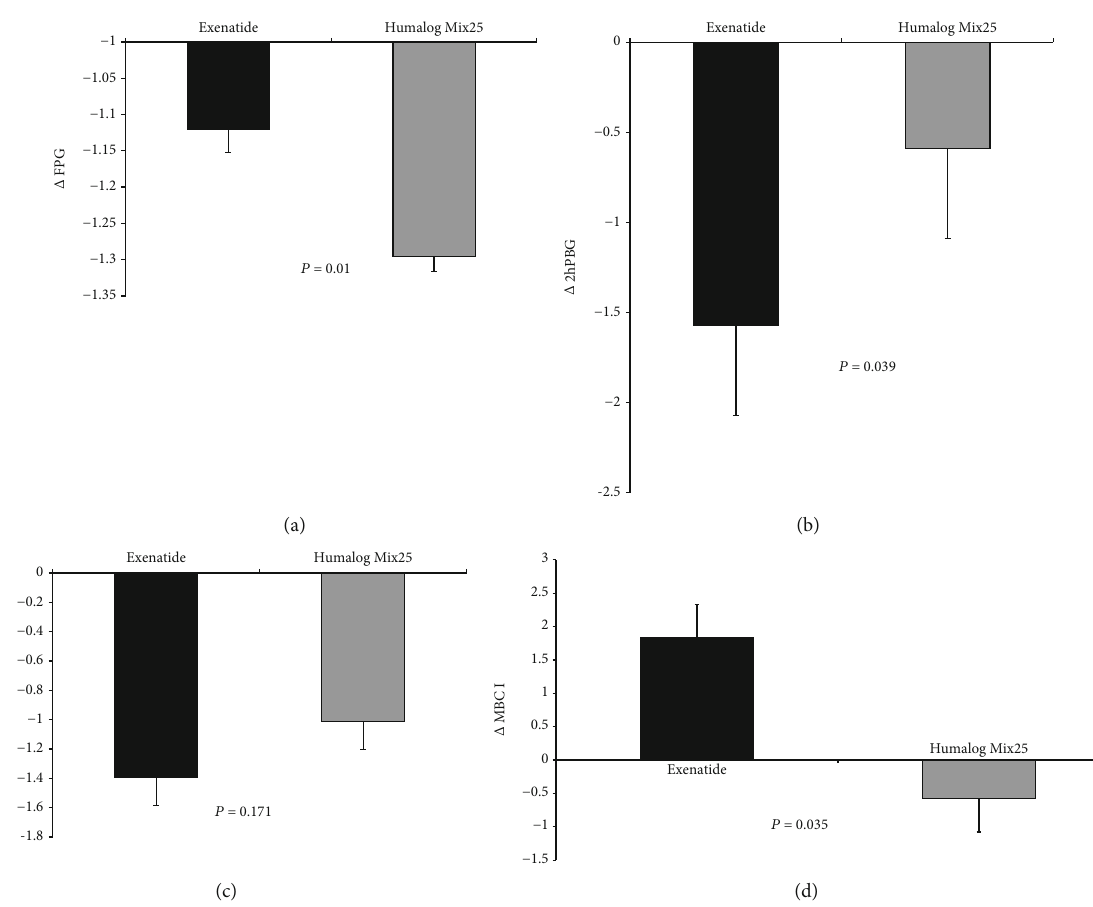
Figure 2: E ff ects of exenatide or humalog Mix25 on glycaemic metabolism and pancreatic β -cell function. Changes in fasting plasma glucose (FPG) (a), 2-hour plasma blood glucose (2hPBG) (b), glycated haemoglobin (HbA1c) (c), and modi fi ed β -cell index (MBCI) (d) after an intervention with exenatide or humalog Mix25 in normal BMI patients with T2DM and visceral adiposity. P values represent comparisons of changes between the two intervention